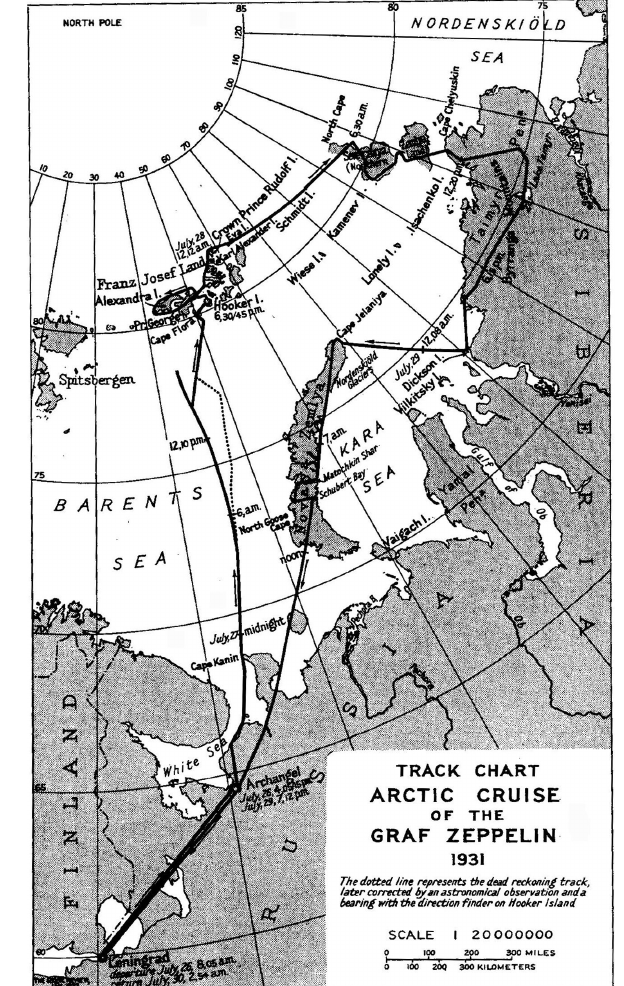
Figure 1. Route of the Graf Zeppelin Arctic flight.